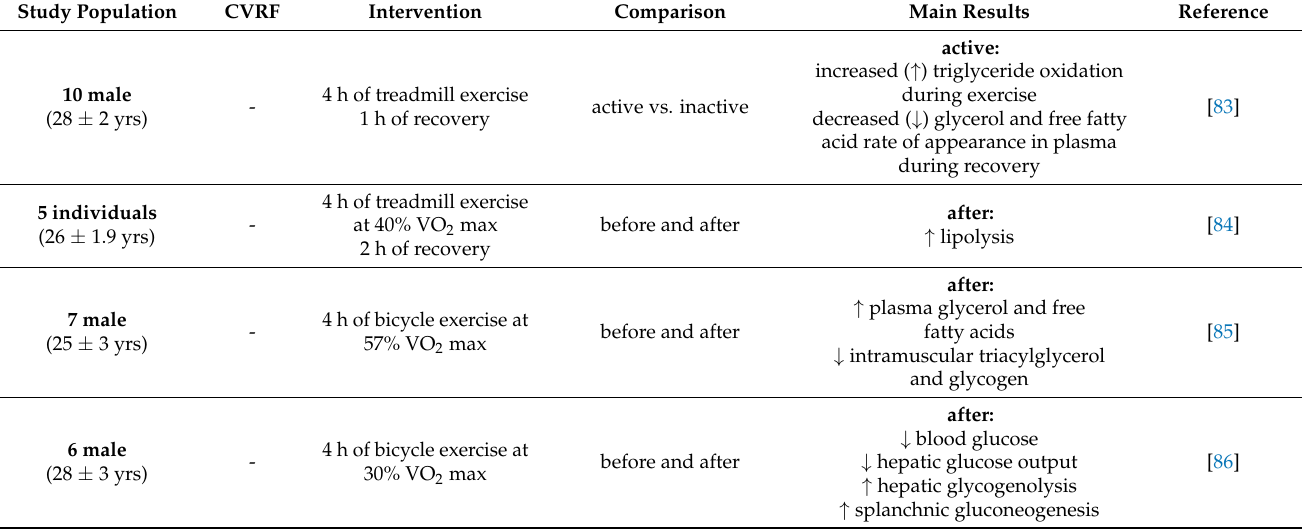
Table 1. Overview of human trials cited in the